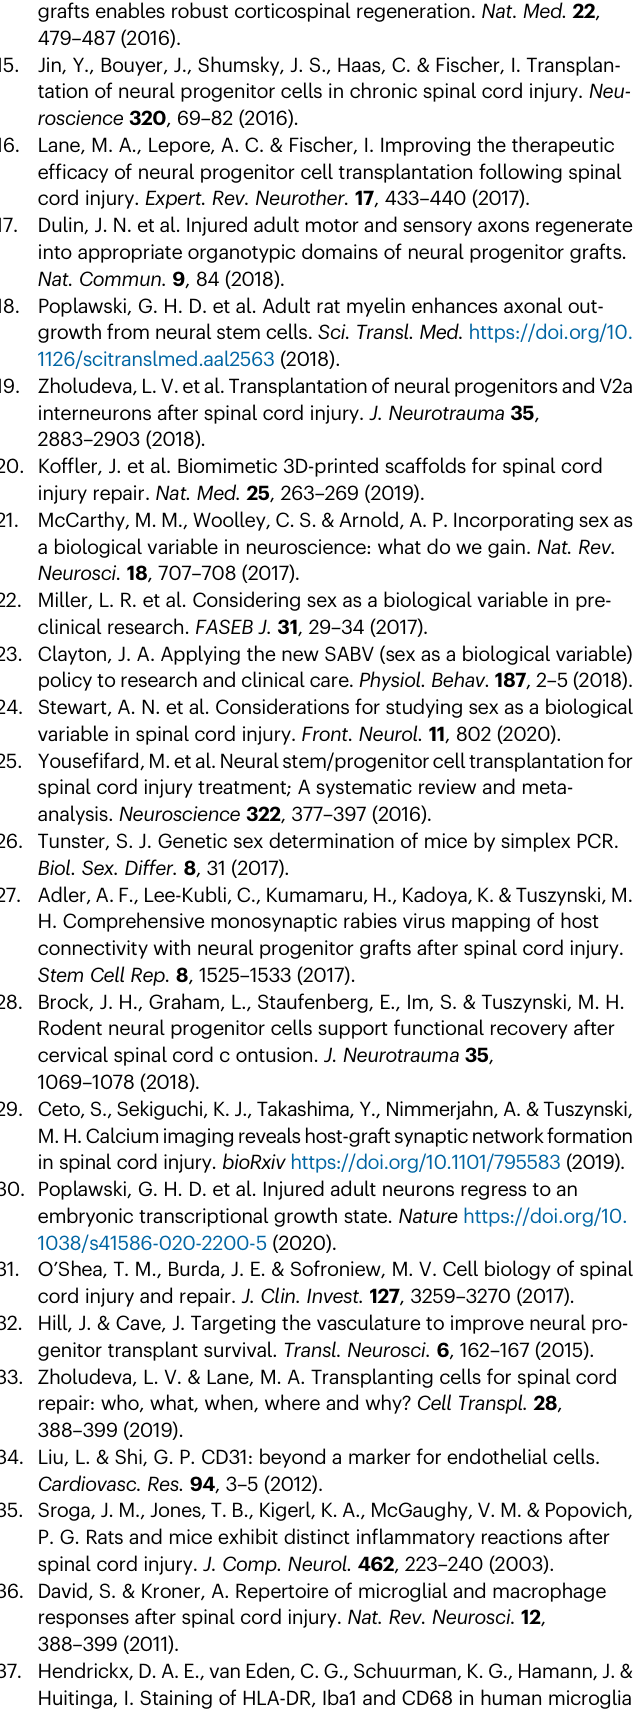
Iba1 quanti fi cation . For each graft ROI, integrated density (the sum of the values of the pixelsinthe ROI)was divided by the number of pixels in the ROI to obtain the mean gray